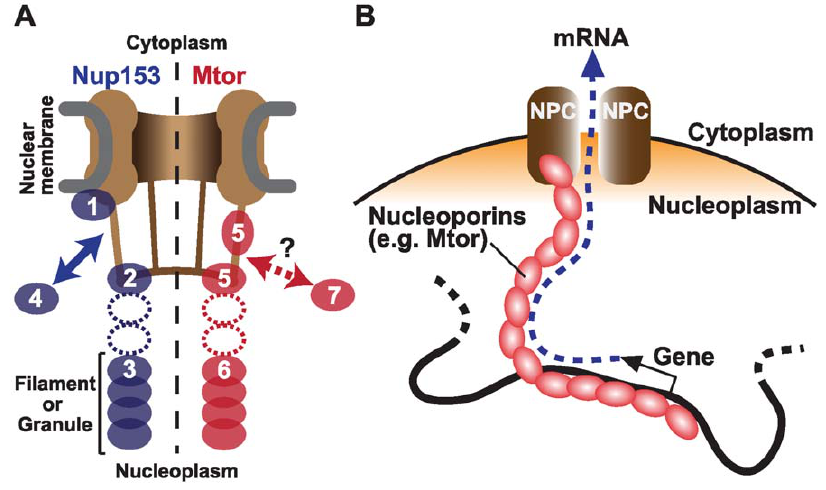
Figure 1. Nucleoporins Nup153 and Mtor are located at both NPCs and the nuclear interior, and associate with active transcription. (A) Schematic representation of Nup153 (left) [13–15] and Mtor (right) [14,16,17] localization at the NPC and the nucleoplasm. Nup153 is proposed to be localized at the nuclear coaxial ring in proximity to the nuclear membrane (1); at the distal pore basket (2); as nucleoplasmic filaments (3); and shuttle between NPCs and the nucleoplasmic pool (arrow, 4). Mtor is proposed to constitute the pore basket (5) and nucleoplasmic filaments or granules (6). The mobile property of Mtor is unknown (7). It is still unclear whether the nucleoplasmic NUP153 and Mtor structures are extended from NPCs (dotted ovals). (B) Possible role of nucleoplasmic nucleoporins in transporting mRNA from the nuclear interior to